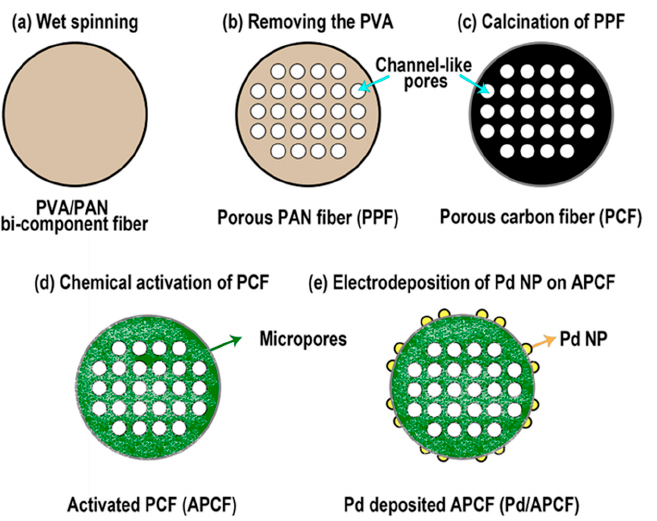
Figure 1. Cross-sectional schematic illustration of ( a ) PVA/PAN bi-component fiber; ( b ) Porous PAN fiber (PPF) fabricated by removing the PVA component from the PVA/PAN bi-component fiber; ( c ) Porous carbon fiber (PCF) prepared by calcination of the PPF; ( d ) Activated PCF (APCF) prepared by chemical activation of PCF; ( e ) Palladium electrodeposited APCF (Pd/APCF).